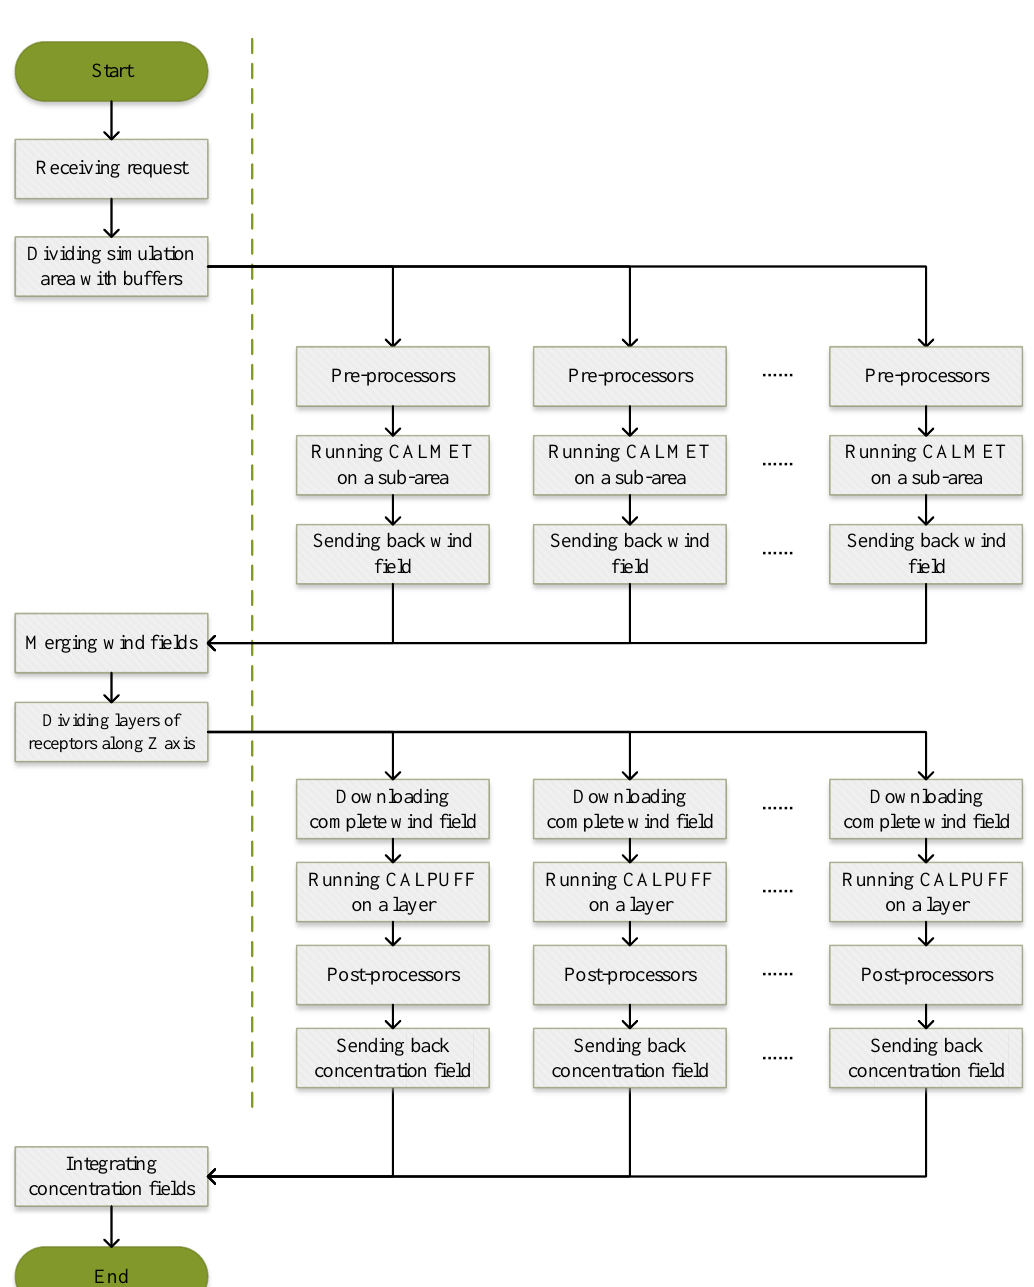
Figure 5. Flow chart of the parallel algorithm.